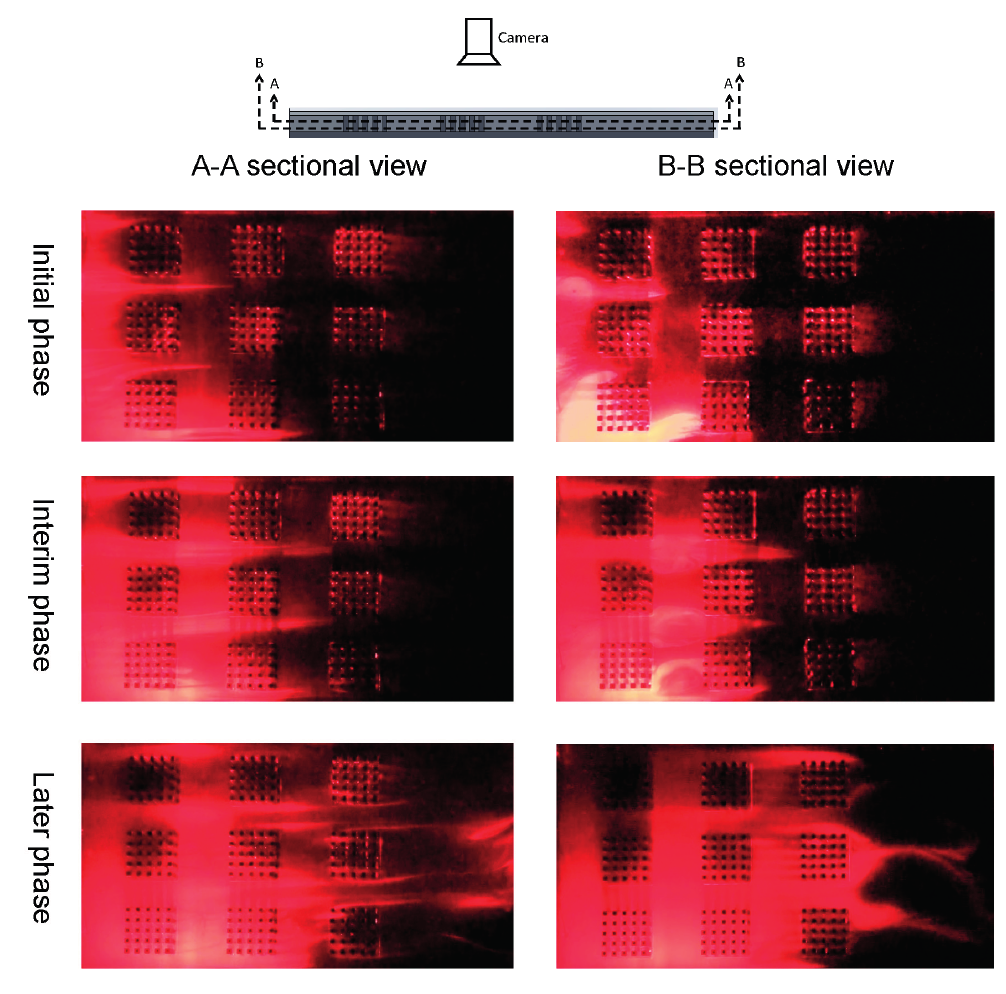
Figure 6. Flow visualization images. ( Re = 52; 15 liter/min). 0.36m/s 0.31m/s Figure 7. Measured values of air velocity at the center column of 3 × 3 heat-sink array. ( Re = 500).